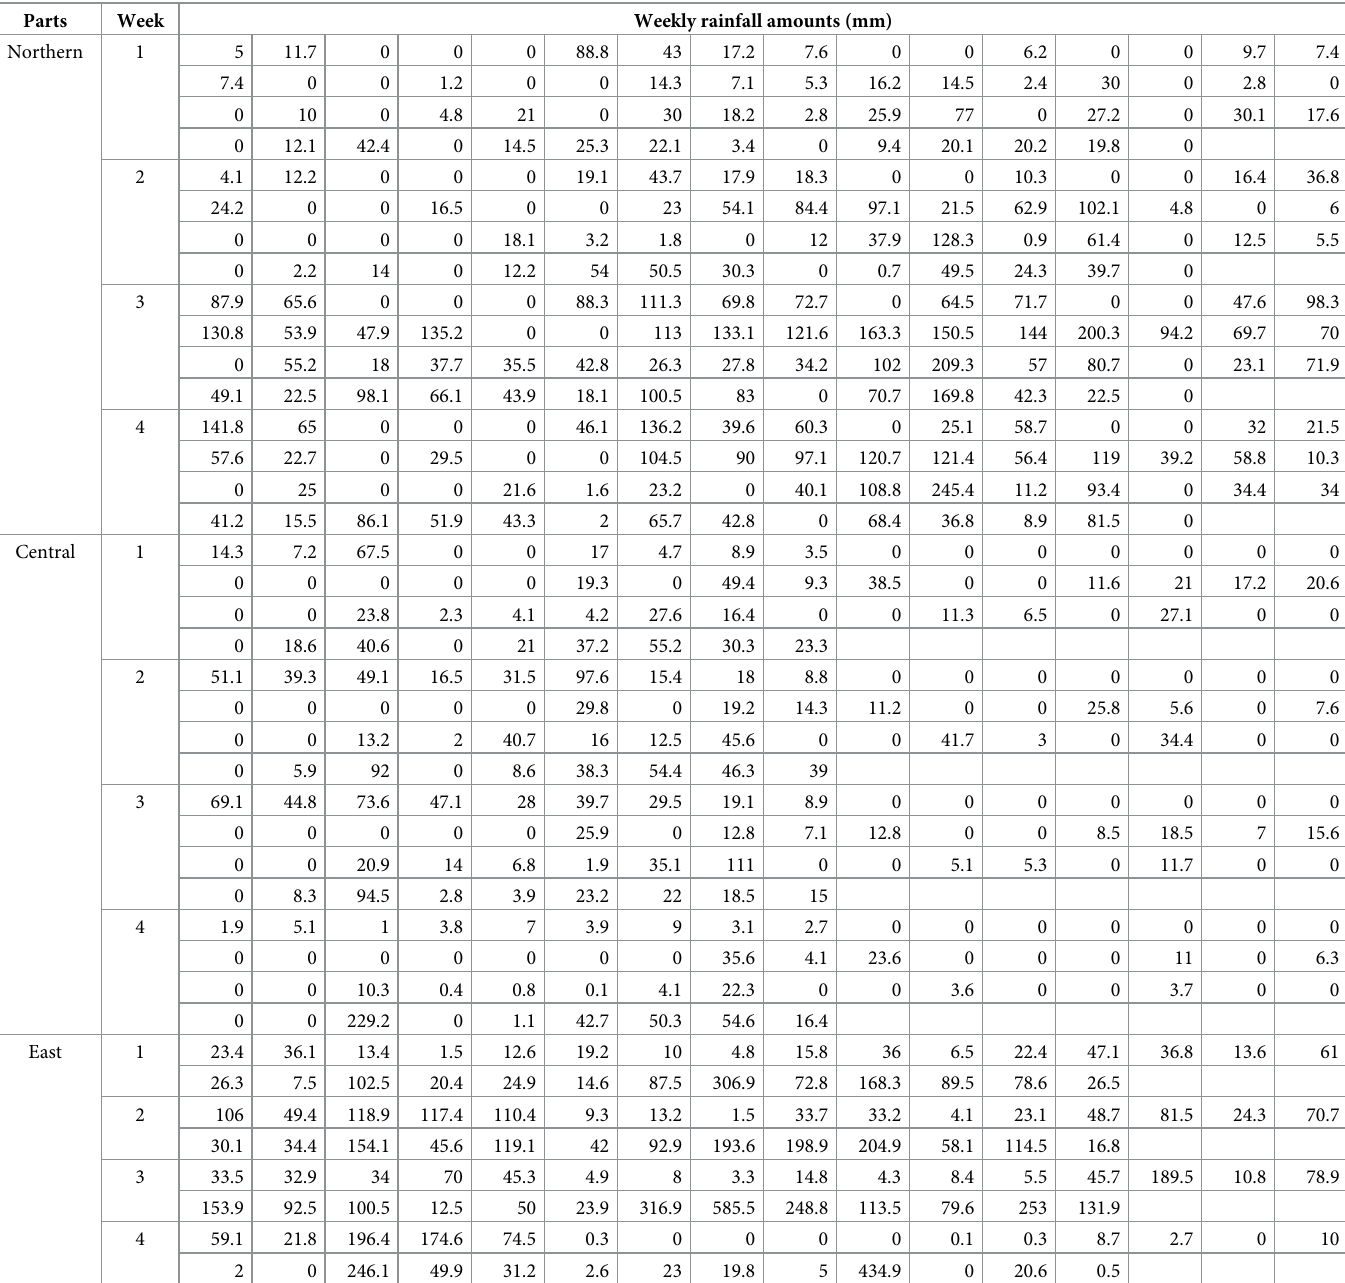
Table 3. Weekly natural rainfall records divided into five parts during July 2018. Parts Week Weekly rainfall amounts